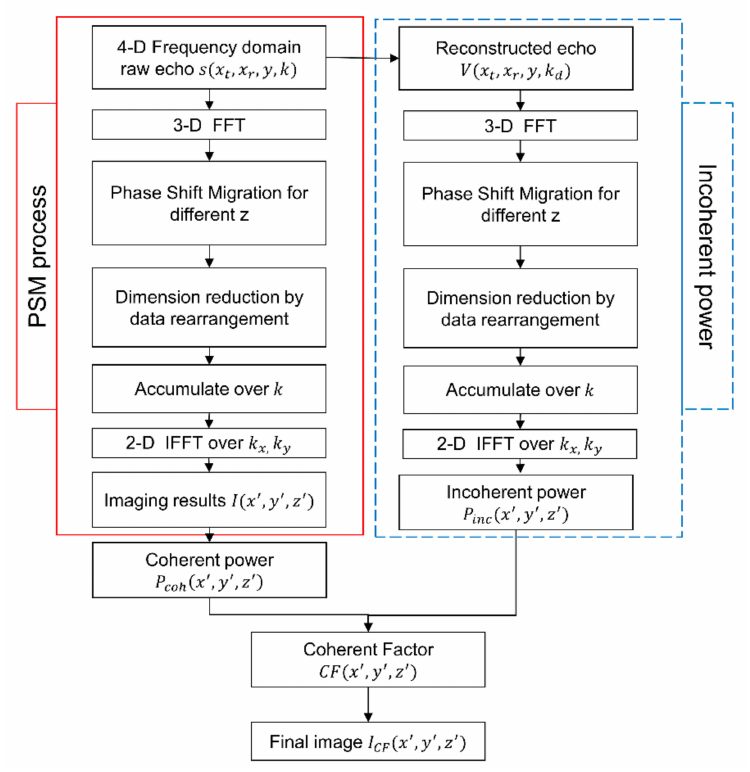
Figure 5. The flowchart of the proposed MCF-PSM imaging algorithm. Table 2. Detailed procedures of the MCF-PSM algorithm